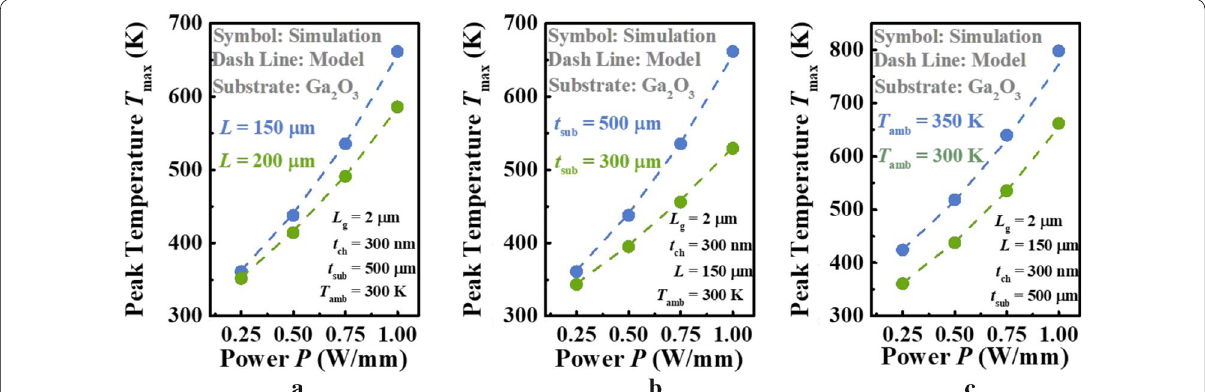
Fig. 3 Dependence of T max on a the length of device L , b the thickness of substrate layer t sub , and c ambient temperature T amb at different power P . Symbols and lines denote the results of proposed model and simulation, respectively